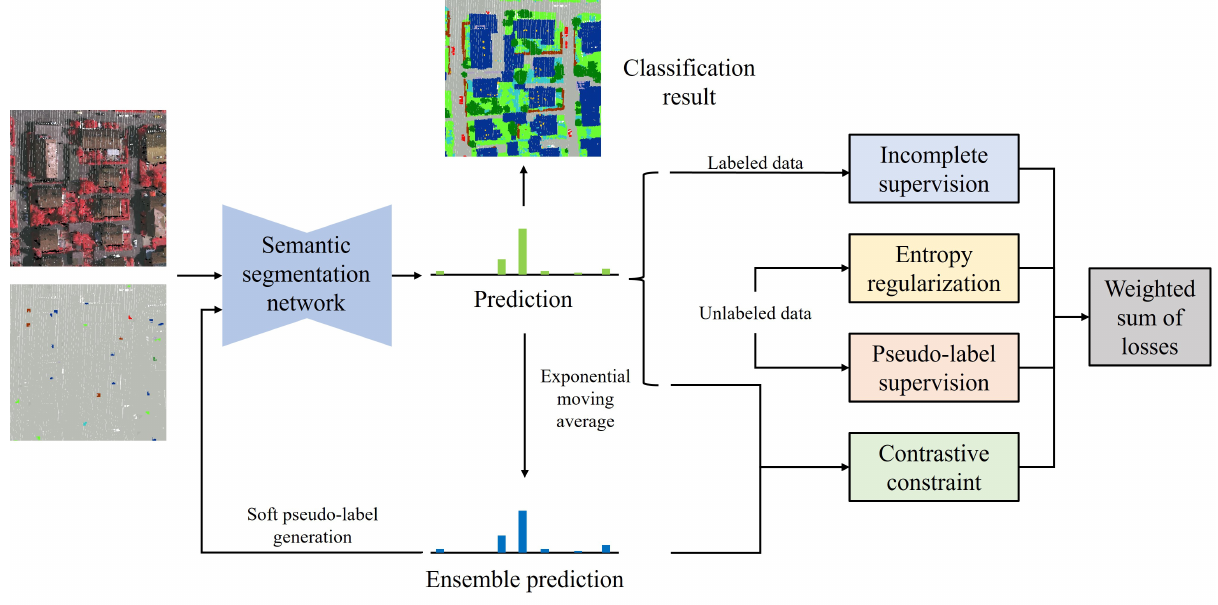
Figure 2. Schematic of the weakly supervised strategy for ALS point-cloud semantic segmentation. Apart from the incomplete supervision of labeled points, three modules are proposed: entropy regularization, contrastive constraint, and soft pseudo-labeling. UMAP optimizes y with respect to fs − set [ x ] cross